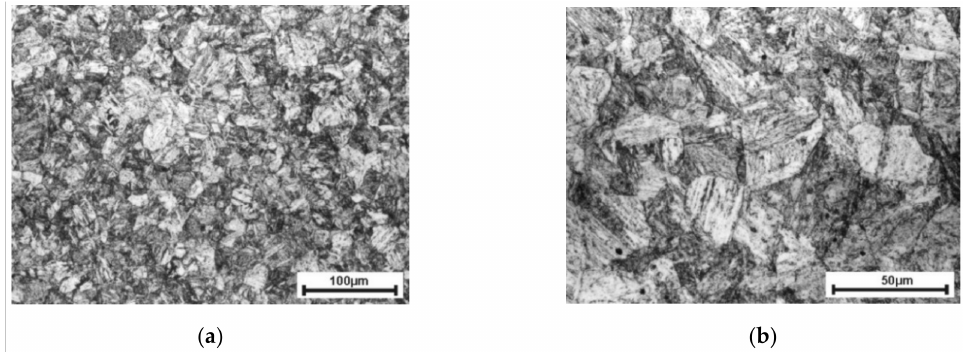
Figure 1. The microstructure of S960QL steel shown at two di ff erent magnifications: ( a ) view of fine grained structure; ( b ) selected grains with bainitic